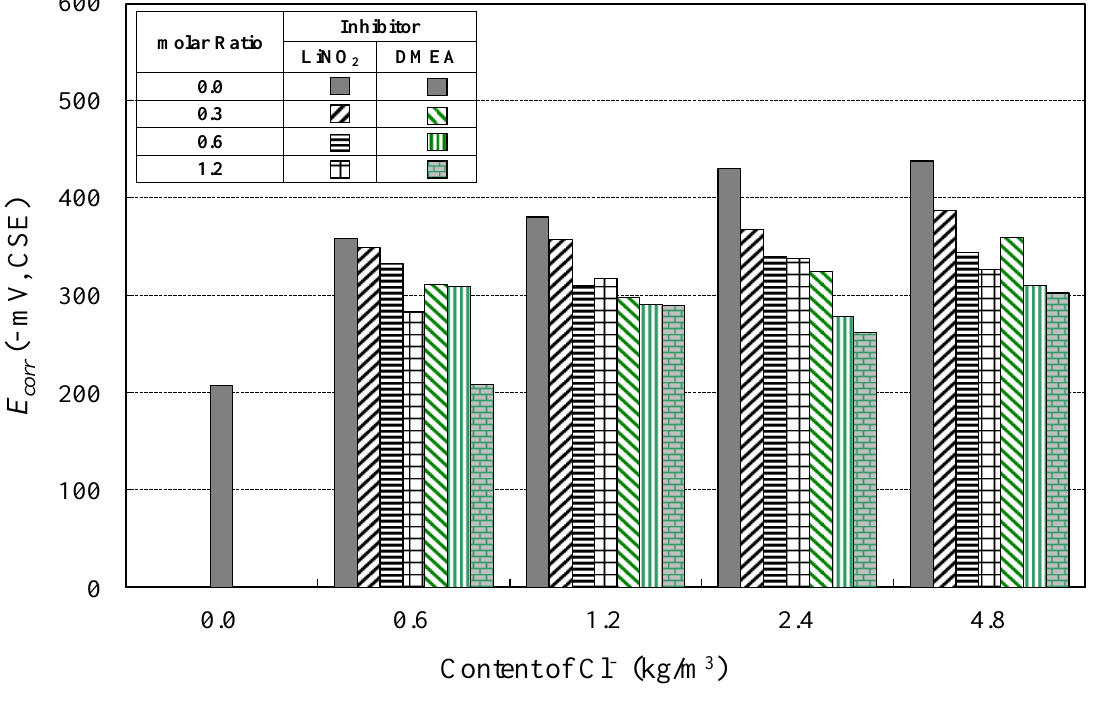
Figure 6. Corrosion potential of the different